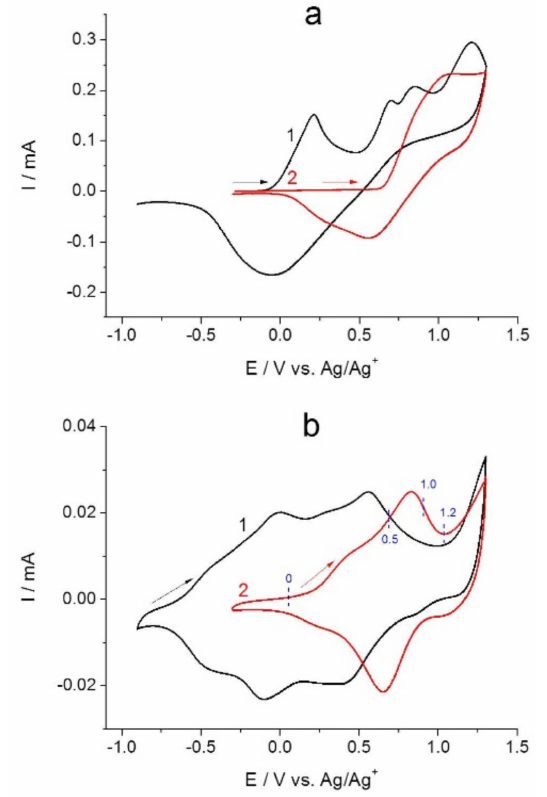
Figure 11. ( a ) Cyclic voltammograms of a Pt-coated quartz crystal electrode (1.37 cm 2 ) at a scan rate of 0.05 V s − 1 in 0.05 M Et 4 NBF 4 /DCE containing 0.001 mol L − 1 [NiAmben] (black curve 1) or 0.001 mol L − 1 [NiSalen] (red curve 2); ( b ) CV curves of a Pt-coated quartz crystal electrode (1.37 cm 2 ) modified with poly-[NiAmben] (black curve 1) or poly-[NiSalen] (red curve 2) at a scan rate of 0.01 V s − 1 (blue numbers indicate oxidation states of